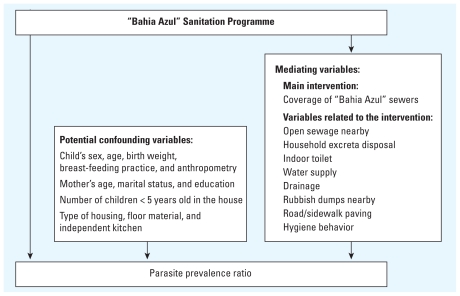
Conceptual model to evaluate the effect of the Bahia Azul sanitation program.